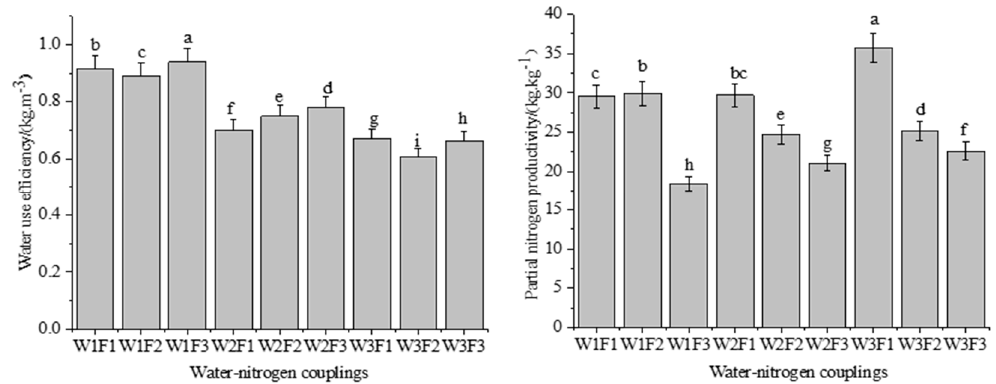
Figure 4. E ff ects of water–nitrogen coupling on water use e ffi ciency and fertilizer partial productivity Figure 4. Effects of water–nitrogen coupling on water use efficiency and fertilizer partial of jujube trees. Note: di ff erent lower-case letters indicate a significant di ff erence between treatments productivity of jujube trees. Note: different lower-case letters indicate a significant difference between ( p < treatments ( p < 0.05).